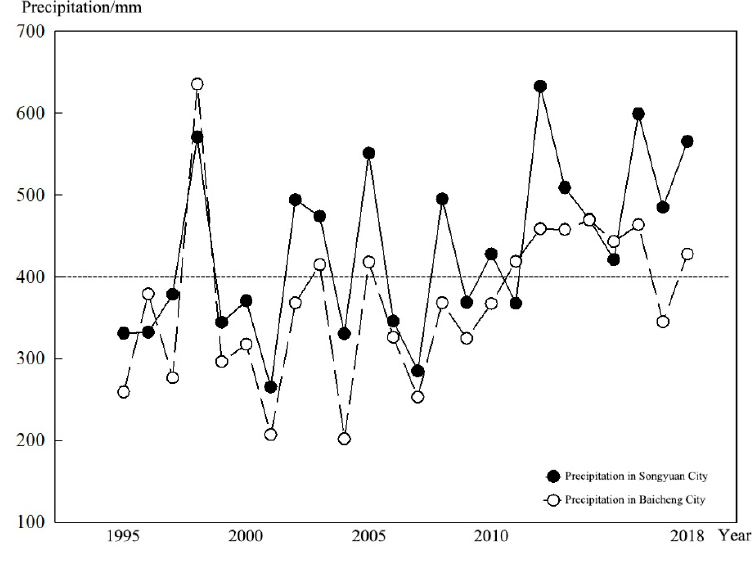
Figure 9. Annual precipitation in Western Jilin.